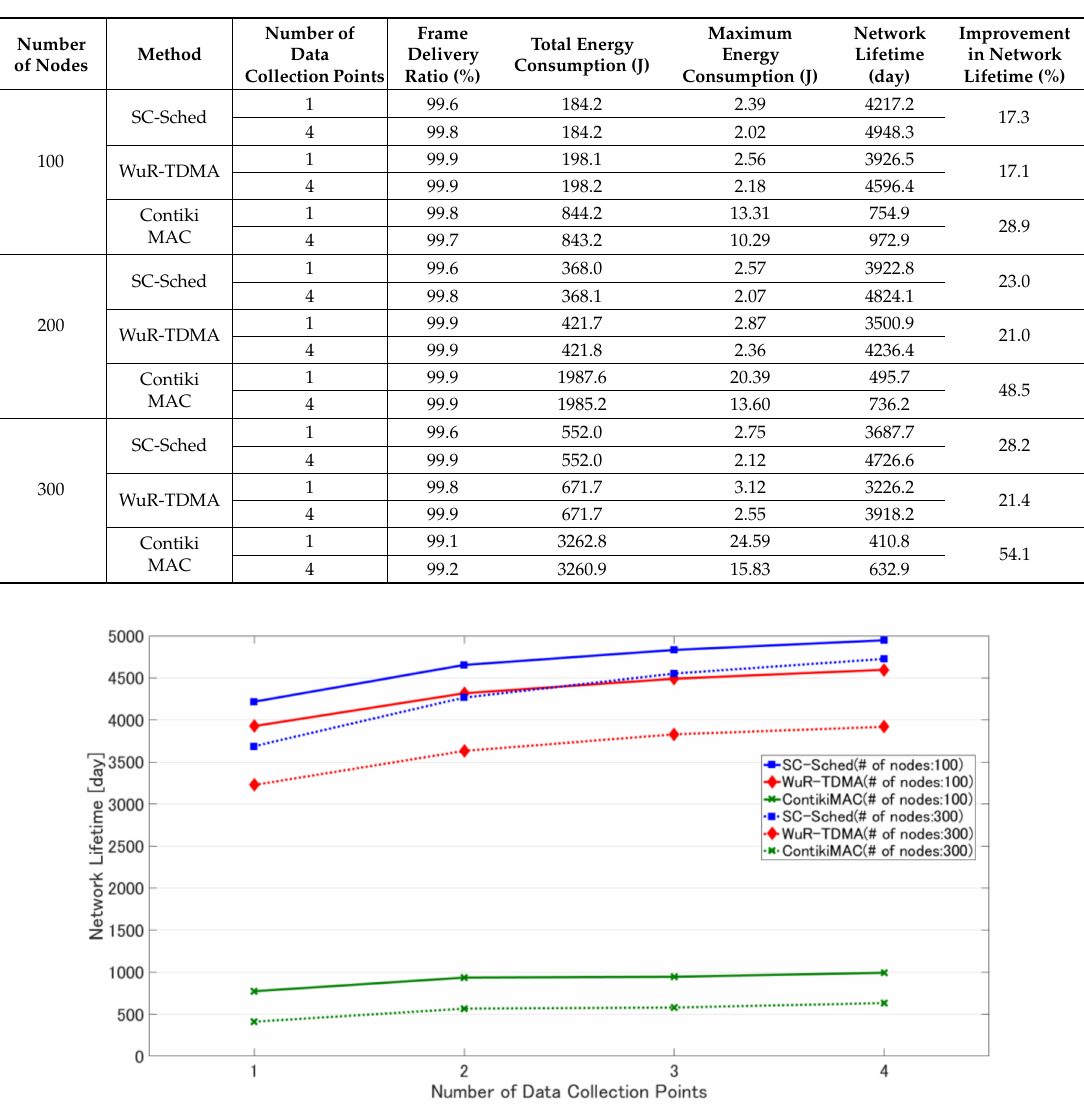
Table 7. Evaluation in the mobile sink scenario.